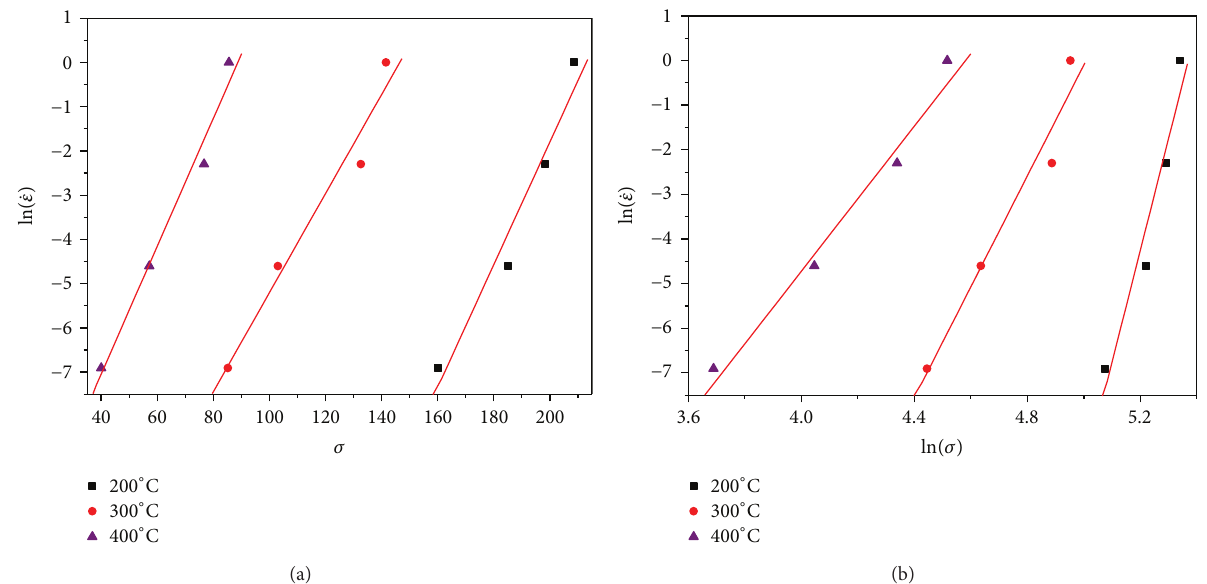
Figure 6: Relationship between strain rate and peak stress of AZ81 magnesium alloy: (a) ln ̇𝜀 − ln 𝜎 ; (b) ln ̇𝜀 − 𝜎